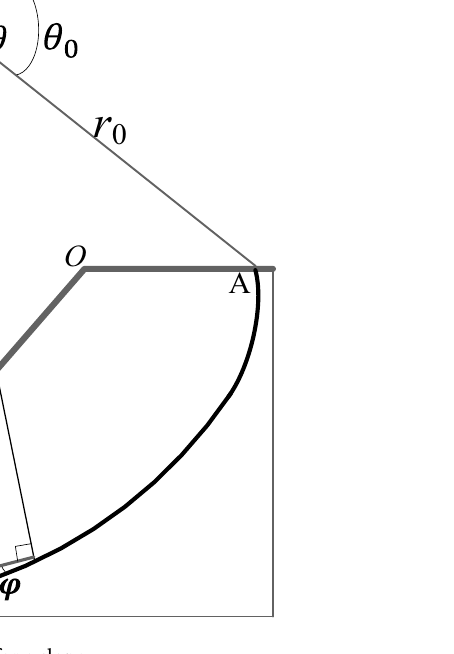
Figure 4. The failure mechanism for a